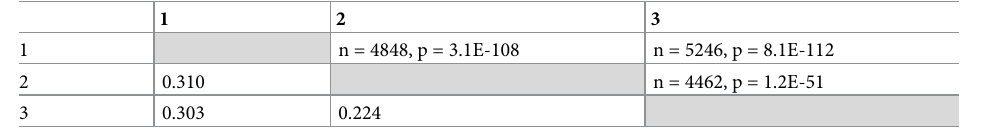
Table 5. Fecal microbiota β diversity is highly correlated between collections � .